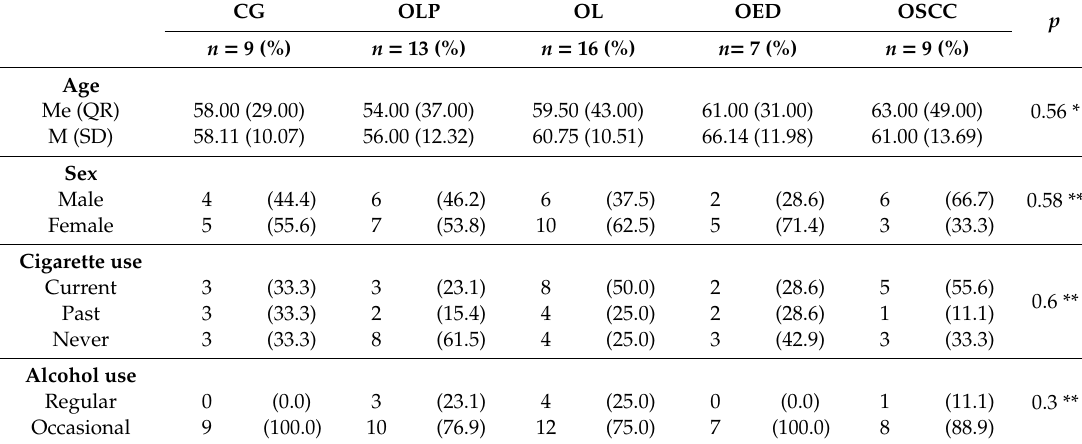
Table 5. Study groups characteristics.